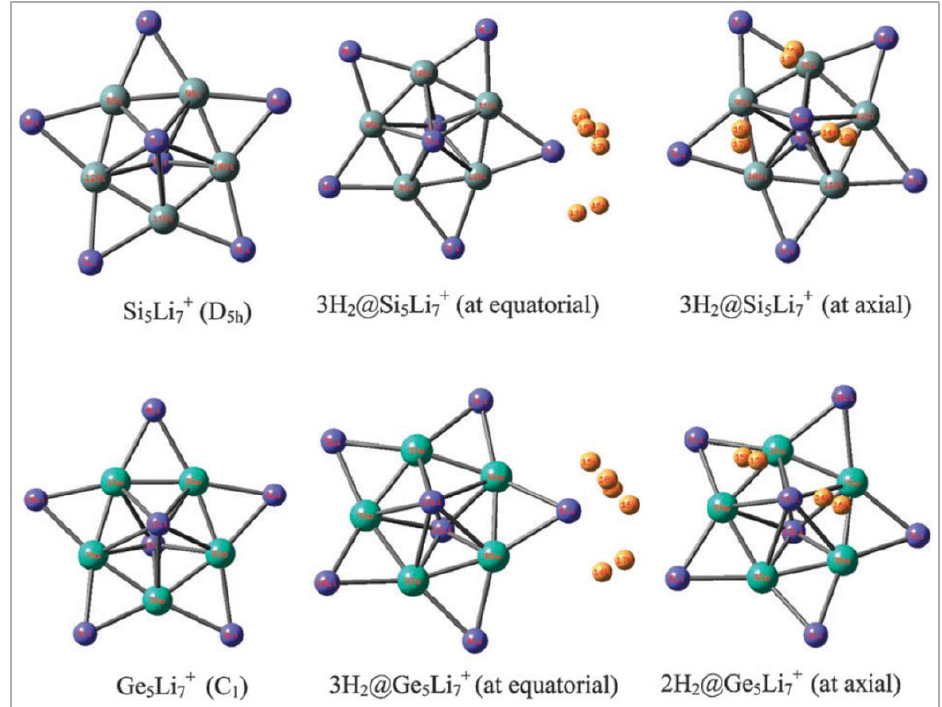
Figure 5. Local minima geometries of M 5 Li 7+ (M = Si, Ge) and their H 2 trapped analogues at the M06/6-311+G(d,p) level. This figure is reproduced from the reference [19].